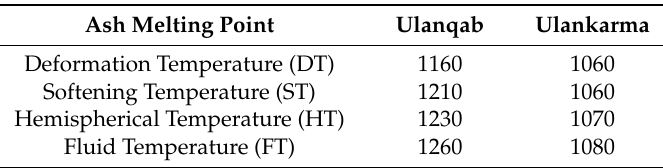
Table 3. Coal ash fusibility ( ◦ C) in a weakly-reducing